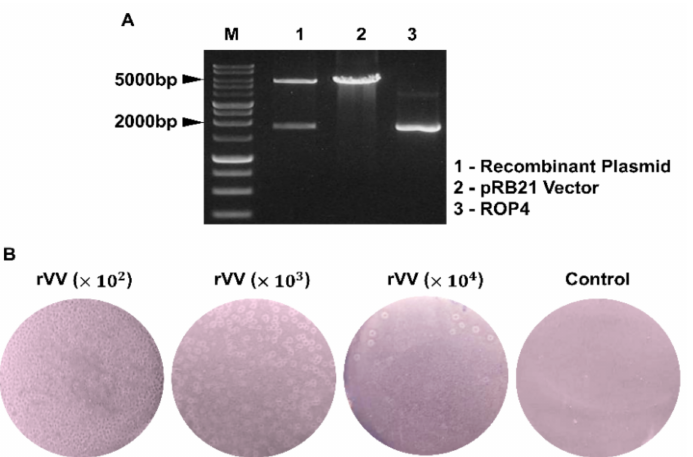
Figure 1. Recombinant vaccinia virus characterization. Recombinant plasmid constructs containing the T. gondii ROP4 gene were cleaved with the restriction enzymes. The size of the ROP4 gene and the pRB21 vectors were 1761 bp and 5537 bp, respectively (M: Marker, Lane 1: pRB21 + ROP4, Lane 2: pRB21, Lane 3: ROP4) ( A ). Virus titers of the ROP4-rVV were determined by plaque assay in Vero cells. Plaques were visualized under a microscope at 4 dpi. Representative images from 3 independent experiments performed in triplicates were acquired at 100 × magnification ( B